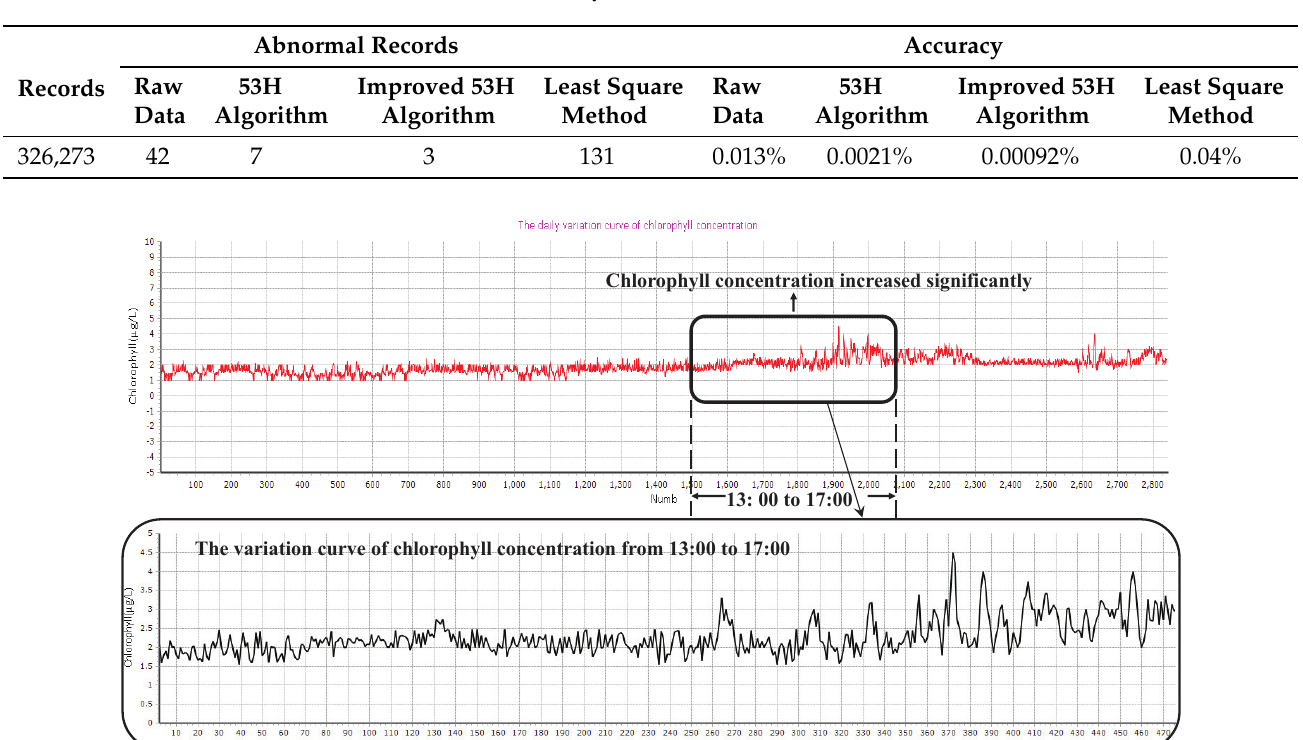
Figure 15. The comparison data curve of turbidity. Table 4. The error rate analysis of sensor data.